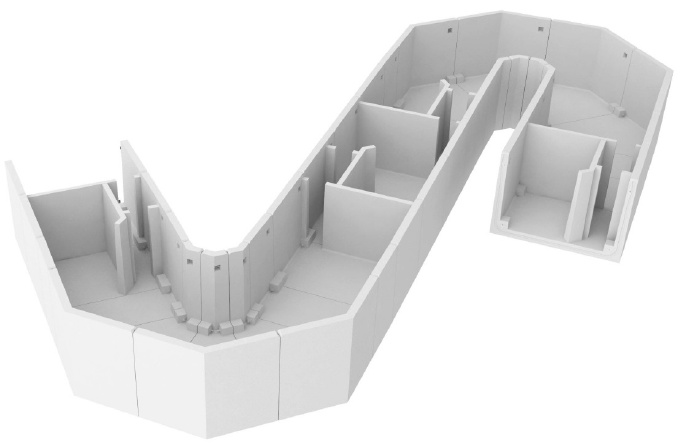
Figure 12. The enature ® fish pass modular construction system of prefabricated concrete elements (Picture: Maba Fertigteilindustrie GmbH).